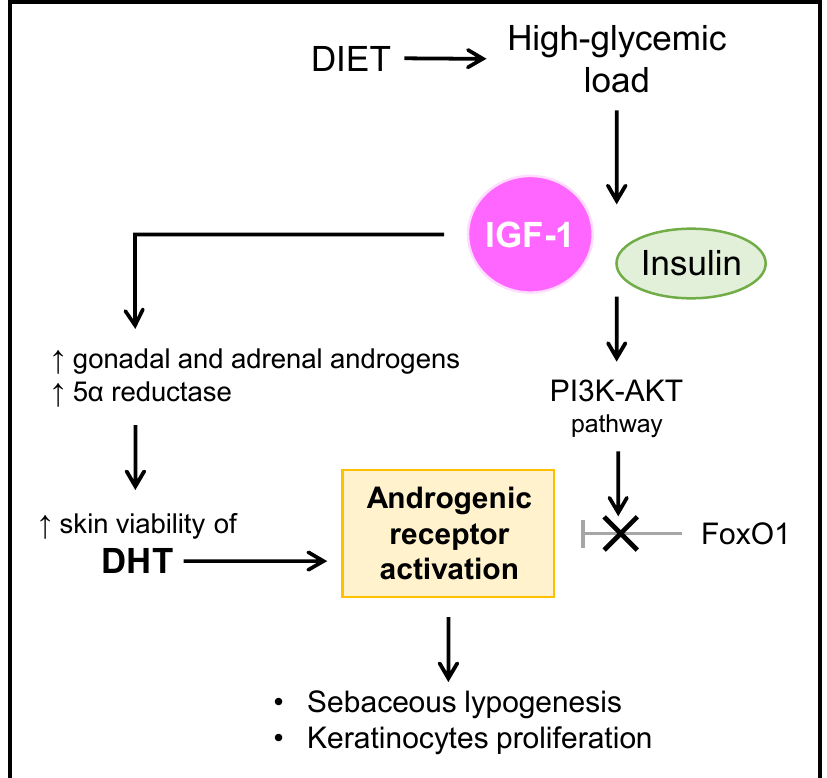
Figure 1. Influence of androgens and IGF-1 in acne. IGF-1: insulin-like growth factor 1; PI3K-AKT: phosphoinositol-3-kinase–protein kinase B (AKT); FoxO1: nuclear forkhead box-O1 transcription factor; DHT: dihydrotestosterone.